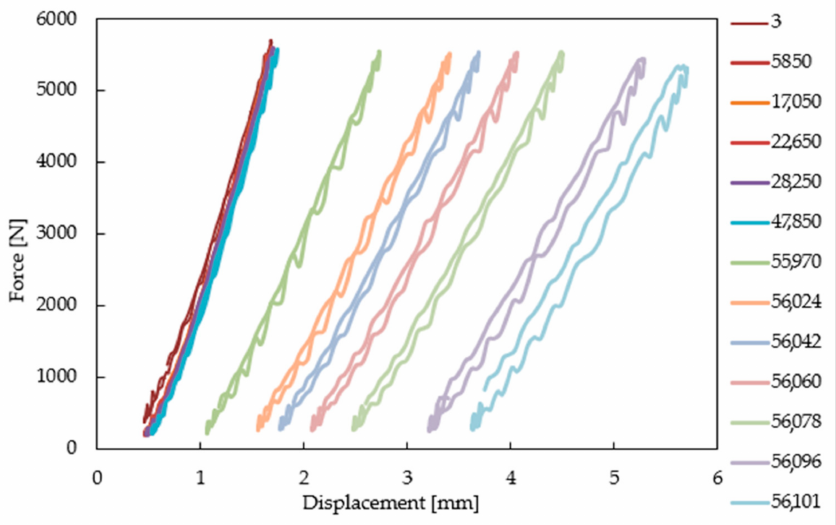
Figure 13. Selected hysteresis loops for the turbine blade subjected to cyclic loads of 5500 N.